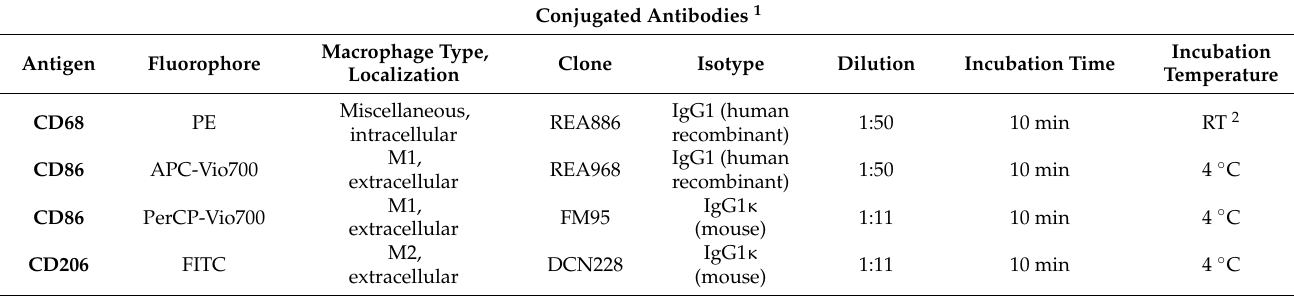
Table 4. Antibodies for immunofluorescence staining for flow cytometry as well as of adherent cells. Summary of antibodies including antigen, fluorophore, macrophage type and localization, clone, isotype and host species, dilution as well as incubation time, and